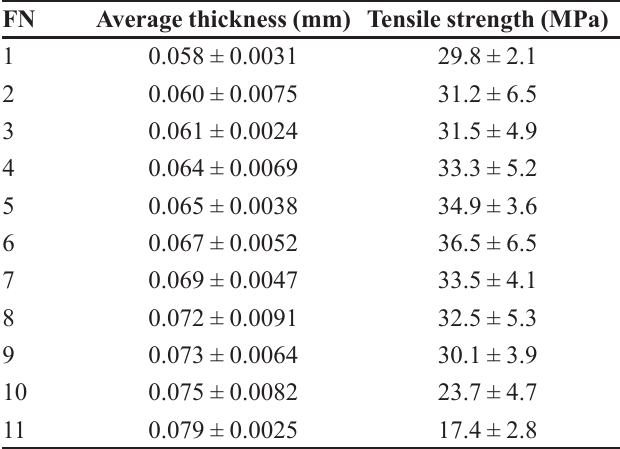
TABLE II - Physicochemical properties of the gelatin/chitosan